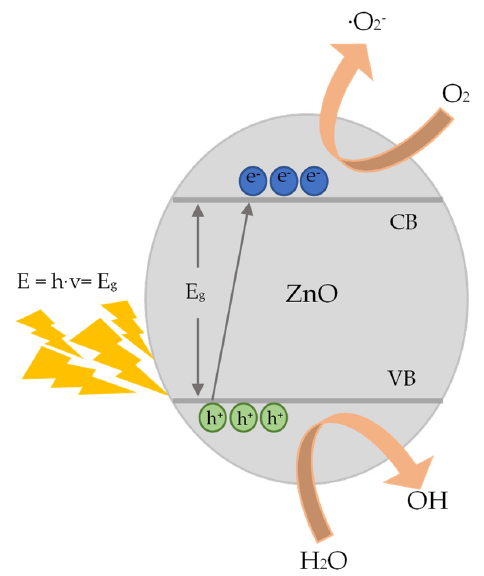
Figure 17. Photocatalytic degradation of RhB (chemical reactions).